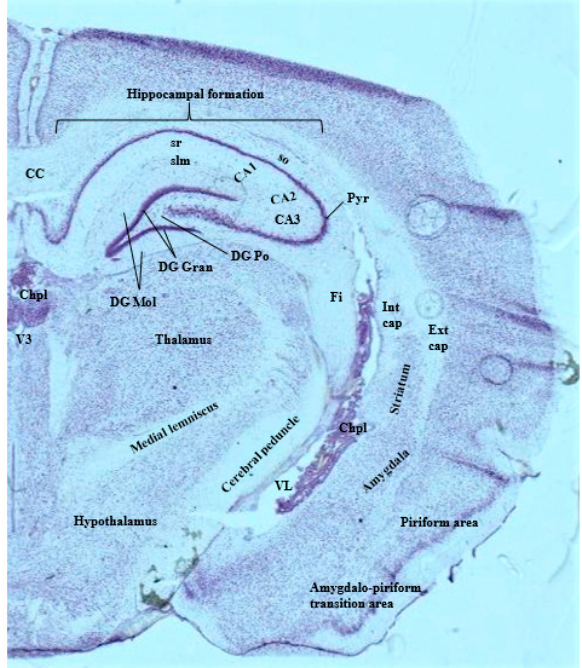
Figure 3. 25 μ m coronal section of a 4-month-old Sprague-Dawley rat brain stained with